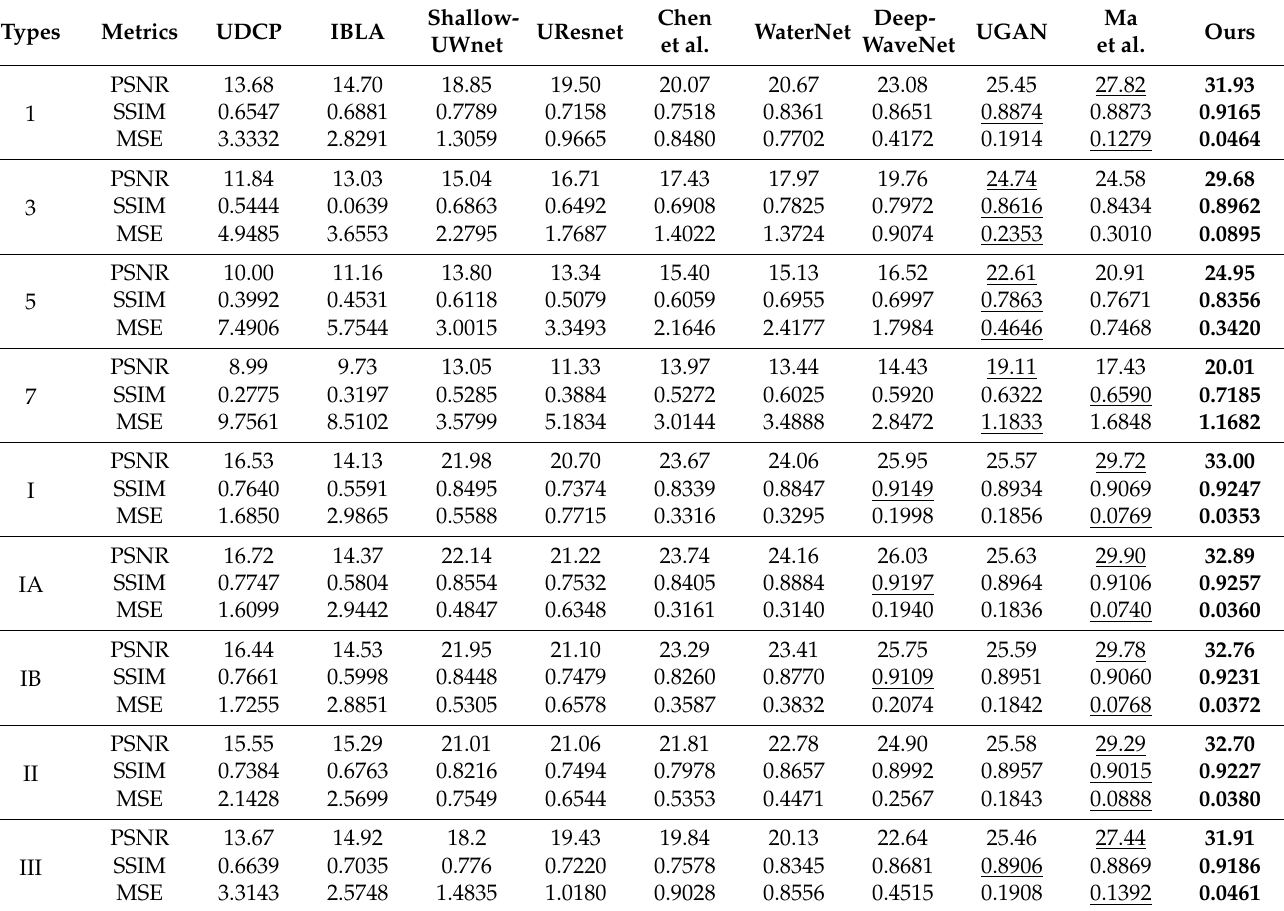
Table 1. Quantitative comparison results of various UIE approaches on the synthetic underwater dataset in terms of PSNR (dB), SSIM, and MSE ( × 10 3 ) values. We present the optimal and suboptimal results with values in bold and underlined,